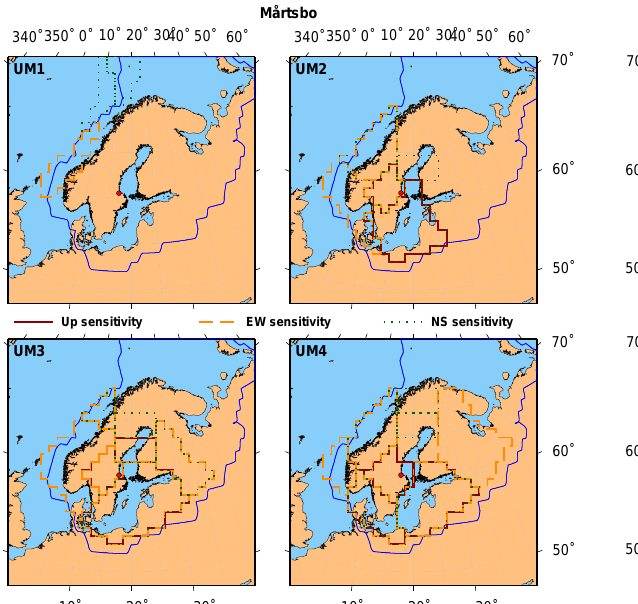
west of the station reflect sensitivity in the EW component. The two stations near the center of rebound, Skellefteå and Vaasa, are sensitive to the largest number of blocks in the second layer. The number of blocks in the second layer is re- duced as the station moves away from the center of rebound. Also, these blocks are generally located in the vicinity of the GNSS station, i.e., within a radius of about 500 km. Svetloe